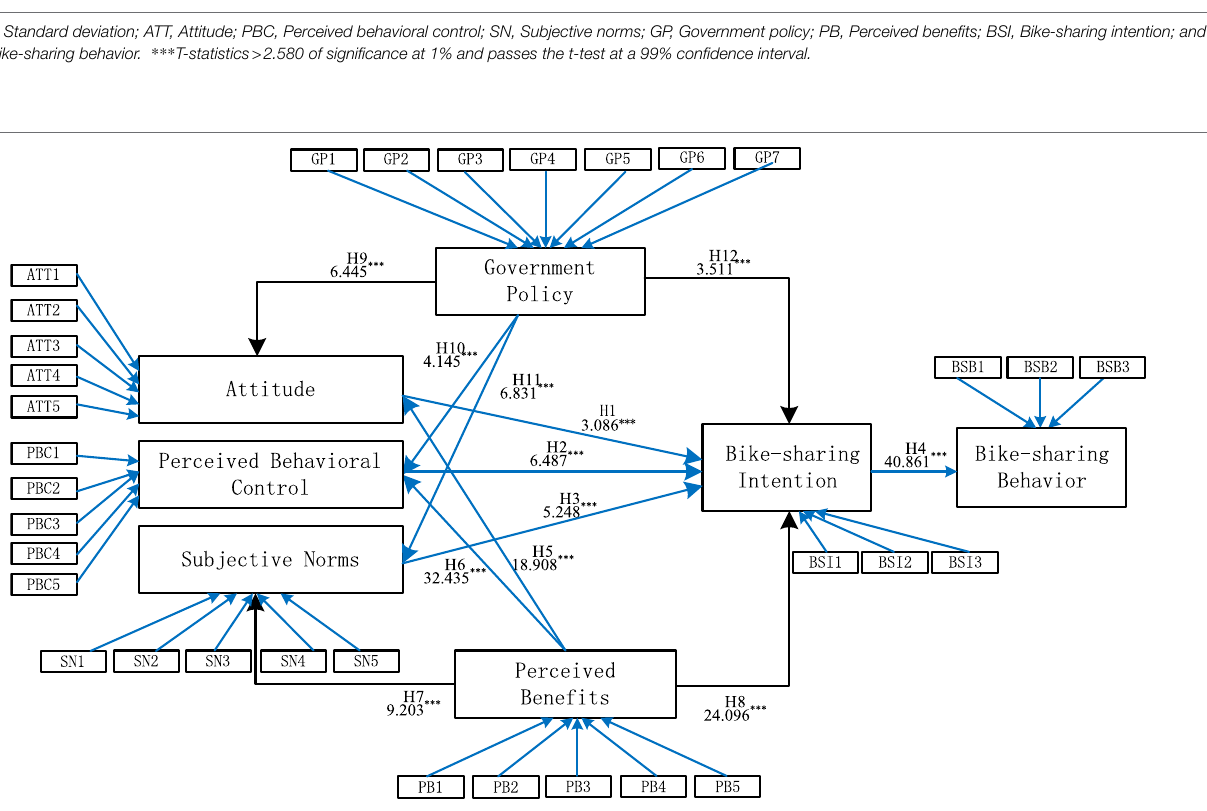
FIGURE 2 | The result of the structural model tests. ( *** means T-statistics > 2.580 of significance at 1% and passes the t -test at a 99% confidence interval).